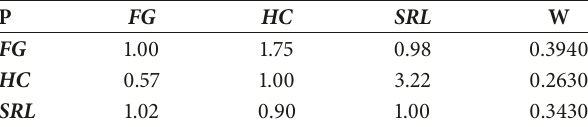
Table 12: Comparison for land use